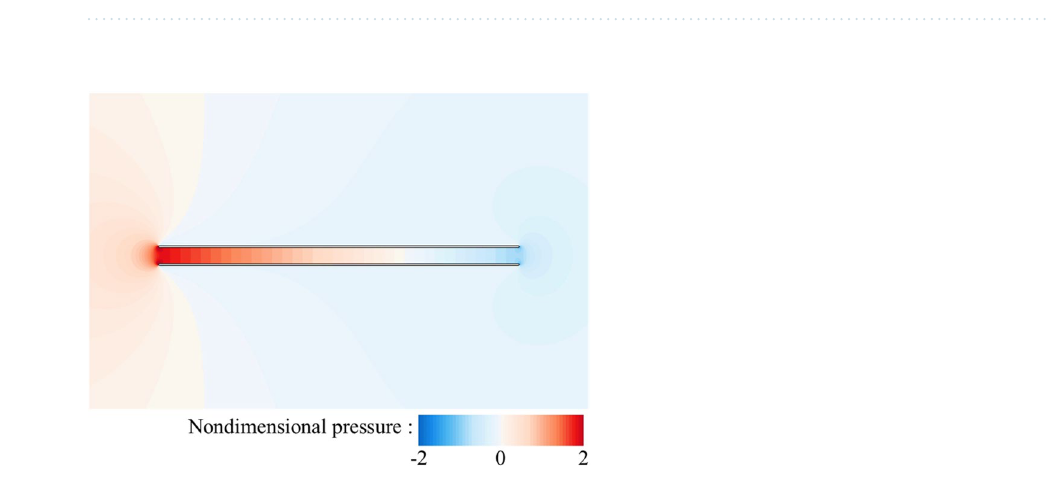
Figure 16. The plot of non-dimensional velocity vector around the leading edge of two flat-plate wings with a smaller distance in between ( W / c = 0.05).